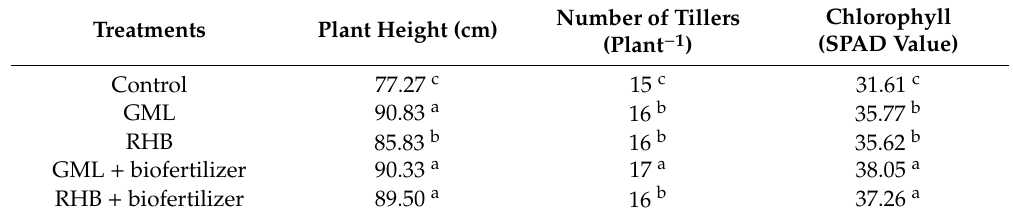
Table 6. E ff ects of applying amendments on plant height, number of tillers and leaf chlorophyll content.